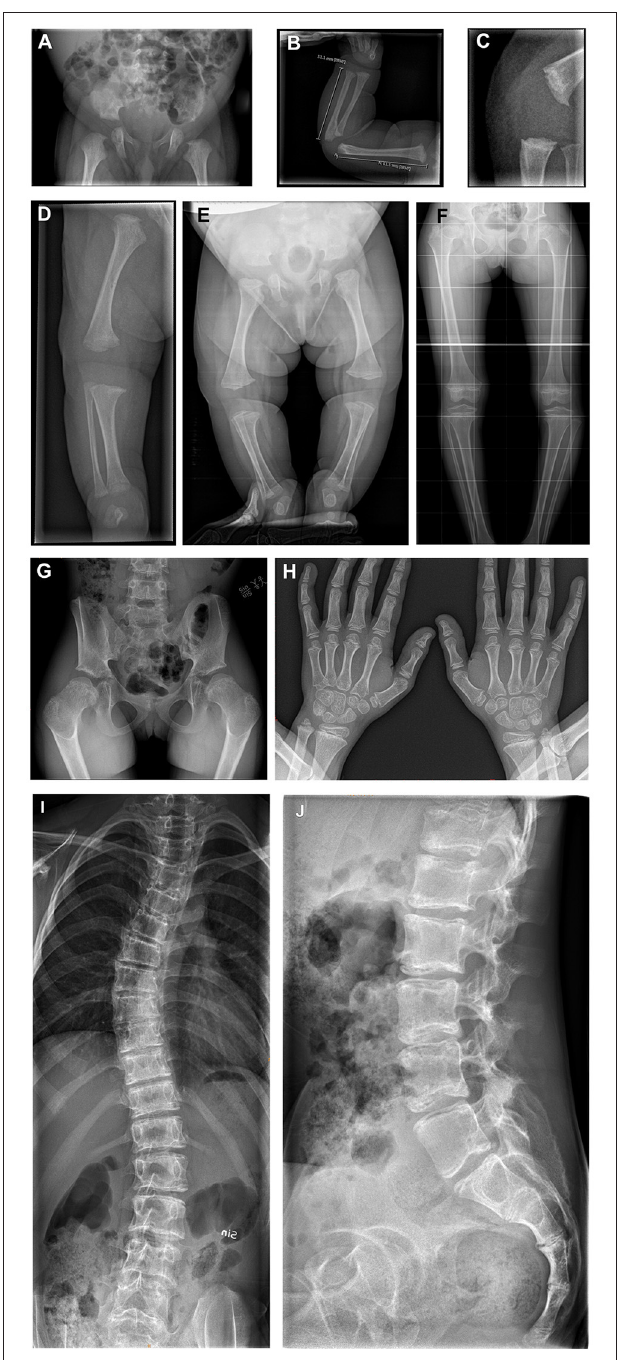
FIGURE 4 | (A) X-rays of the skeleton of patients 3, 4, and 6. (A–D) Patient 3 at age 4 days; born with multiple congenital abnormalities of the bones. (A) The pelvis shows flat acetabula and short femoral necks. (B) The right arm demonstrates metaphyseal widening and irregularity. (C) The knee in the lateral view demonstrates metaphyseal irregularity in detail. (D) The image of the right leg demonstrates irregularly widened metaphyses at the distal femur and proximal and distal tibia, with a dysplastic knee joint and varus deformity. (E) Patient 4 at age 4 months; total legs, demonstrating flat acetubular roofs, wide femoral head metaphyses with short femoral necks. There is slight